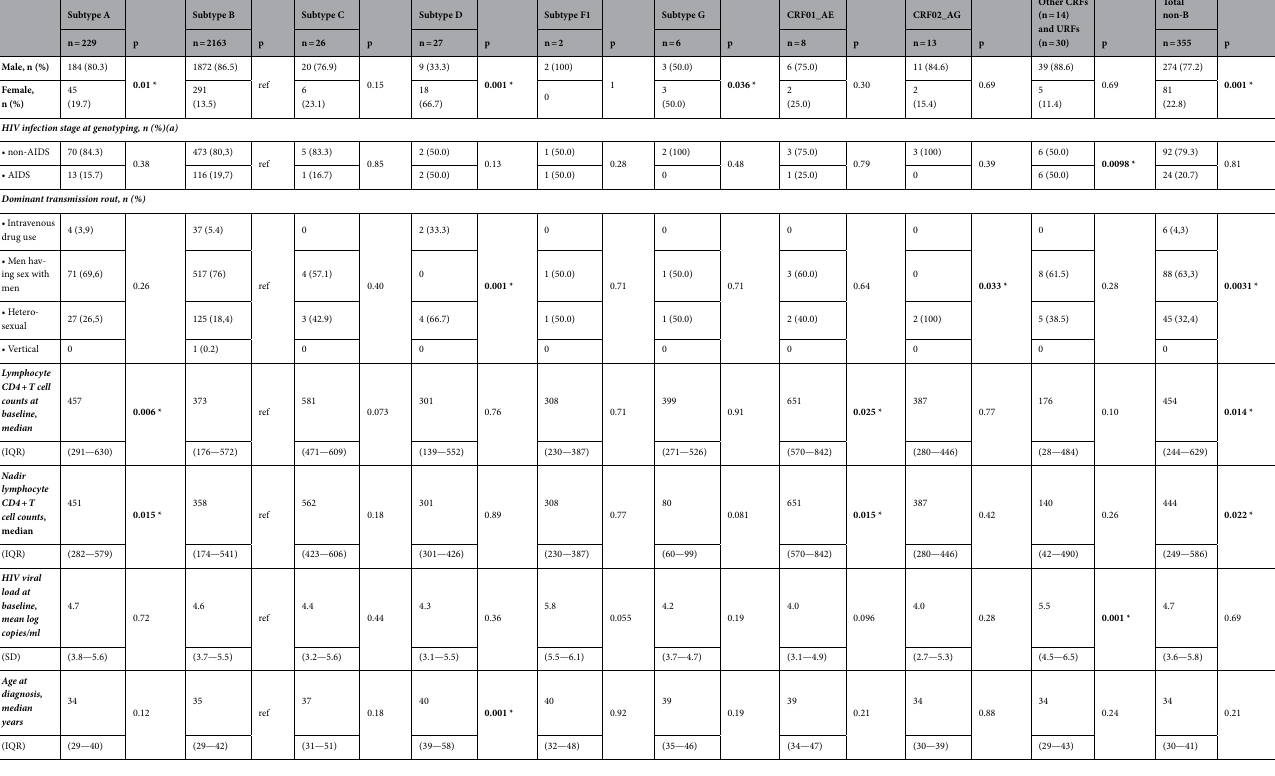
Table 1. Group characteristics across the analysed subtypes and differences compared to the subtype B. (a) HIV infection stage available for 705 patients, transmission route for 819 patients, baseline lymphocyte